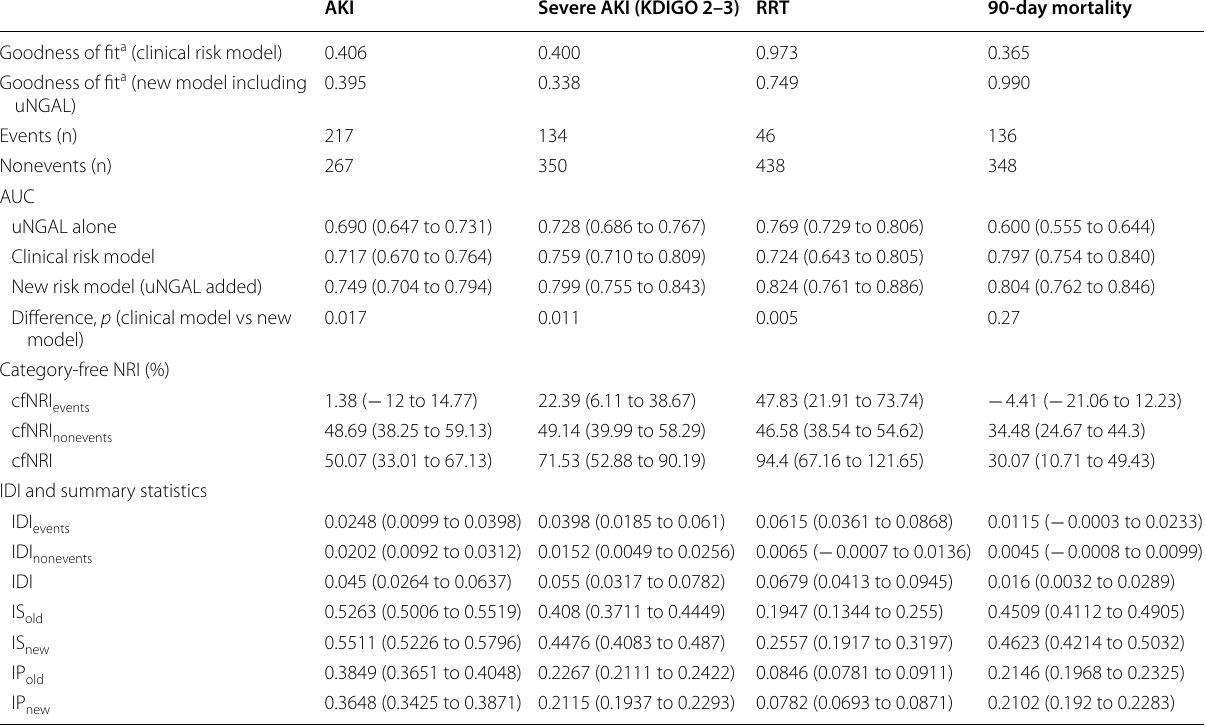
Table 2 Model improvement with urine NGAL added to the clinical risk models for the